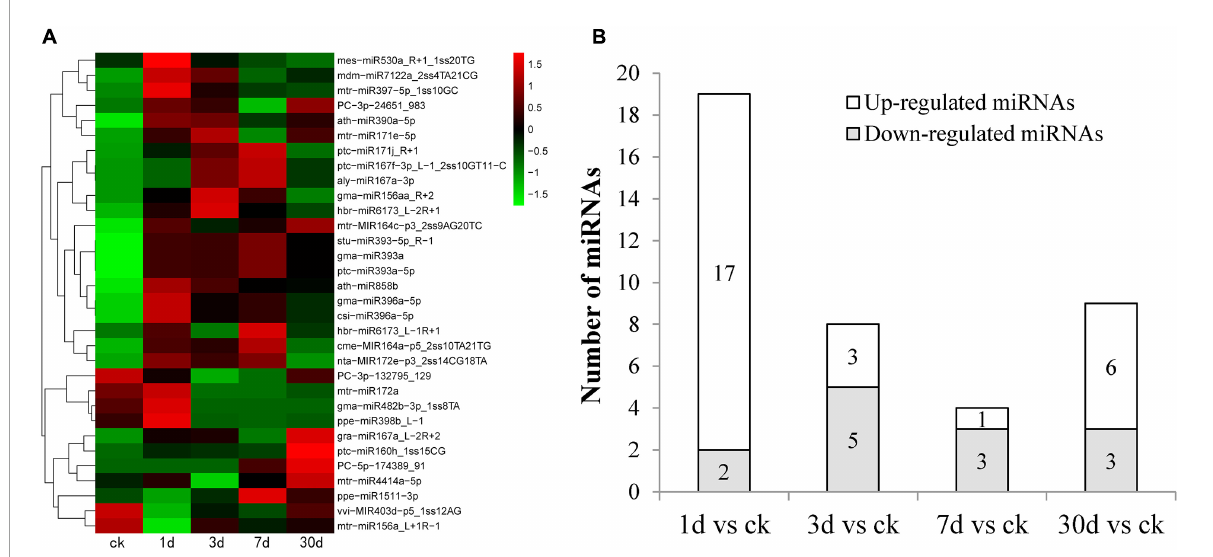
FIGURE3 Phosphorus (Pi) deficiency and miRNAs in C. oleifera . (A) Differential expressed miRNAs in five different low Pi treatment durations (CK, 1, 3, 7, and 30 days) by miRNAs hierarchical clustering. Red indicates higher levels of miRNAs and green indicates lower levels of miRNAs. The names of the samples are shown at the bottom. The original expression values of the miRNAs were normalized using Z-score normalization. The absolute signal intensity ranges from − 1.5 to + 1.5, with corresponding color changes from green to red. (B) The number of differentially expressed miRNAs under Pi deficiency compared with the